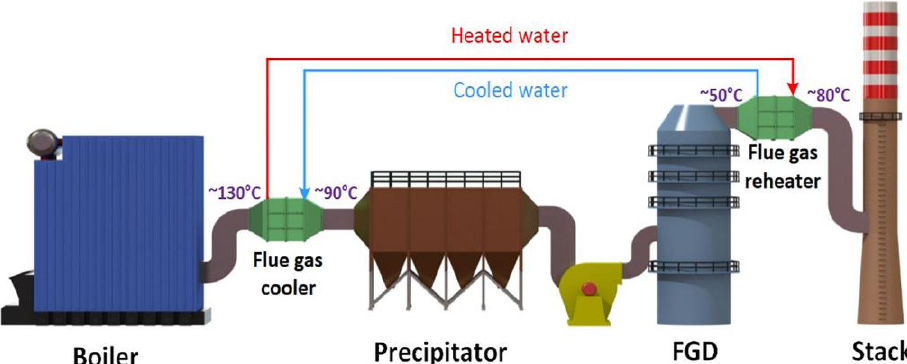
Figure 9. The back end of a coal-fired heating plant. Reproduced with permission from Pan et al. [126]. Copyright 2018 Elsevier Ltd.